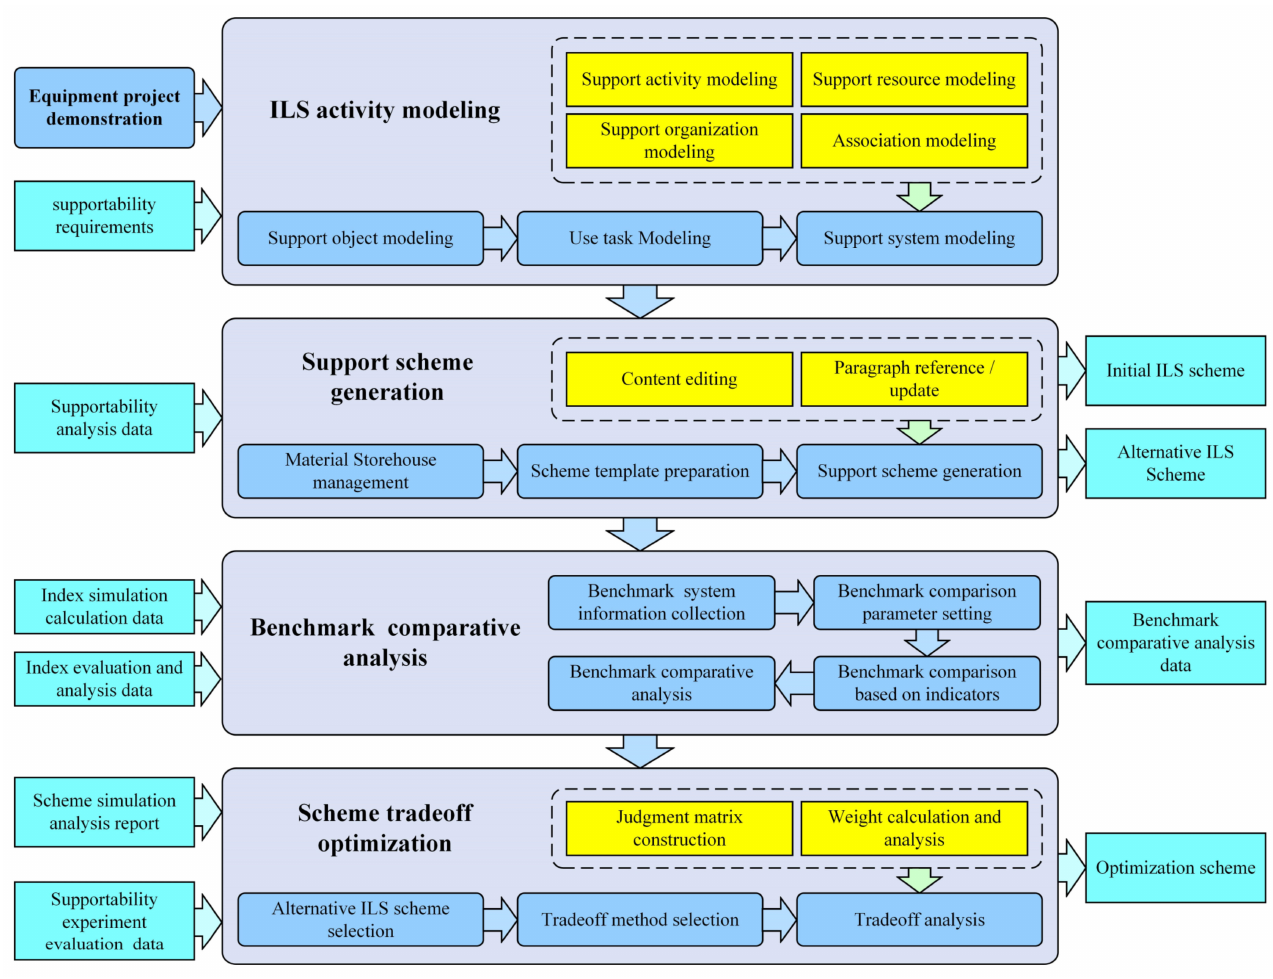
Figure 3. The ILS scheme determination activity and related data